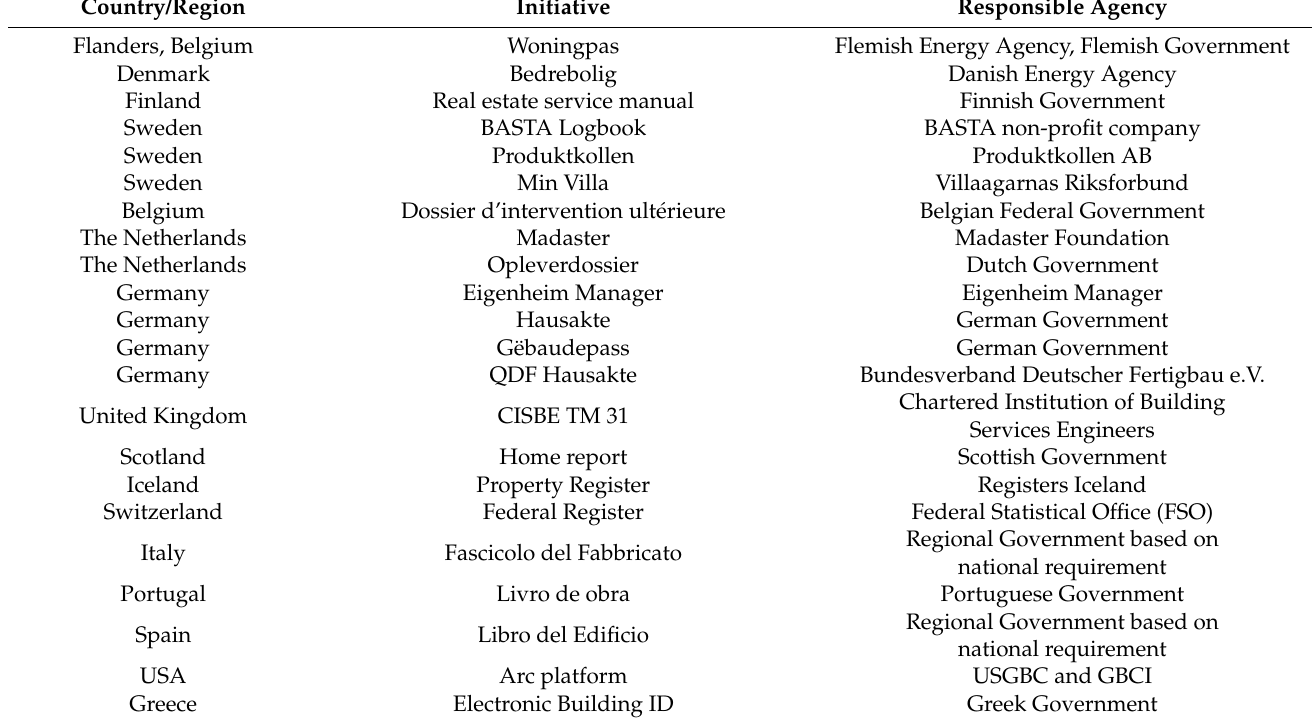
Table 1. Summary of building logbooks currently